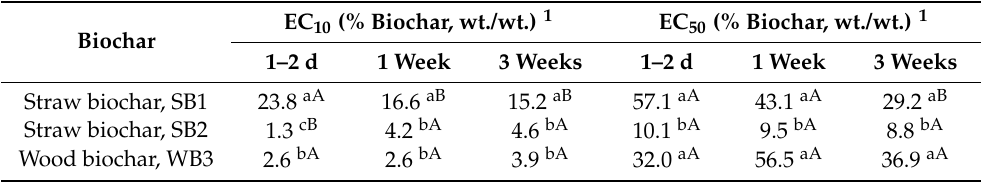
Table 2. Effect concentrations (EC 10 and EC 50 ) for ecotoxicity of biochars to potential ammonia oxidation (PAO) in agricultural soil. PAO was measured after soil/biochar interaction for 1–2 days, 1 week, and 3 weeks. Small letters indicate significant differences ( p < 0.05) between biochars and capital letters indicate significant differences between interaction